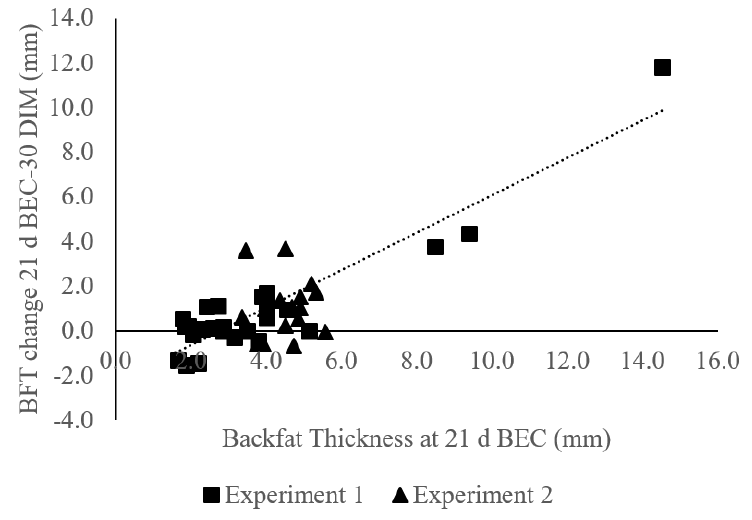
Figure 4. The relationship between backfat thickness (BFT) at 21 d before expected calving (BEC) and the change in BFT from 21 d BEC to 30 days in milk (DIM) from the first experiment ( ∎ ; n = 25) and second experiment ( ▲ ; n = 16). The greater amount of BFT cows have at 21 d BEC, the more BFT they mobilize from three weeks prepartum through 30 DIM (R 2 = 0.87). Negative BFT mobilized is equivalent to adipose accretion over the time points measured.